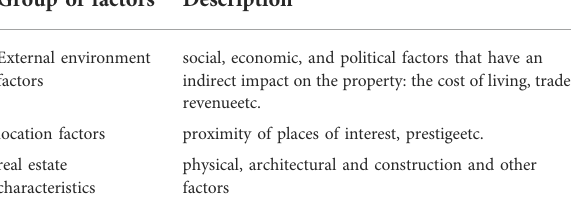
TABLE 1 Grouping of pricing factors of the cadastral value.